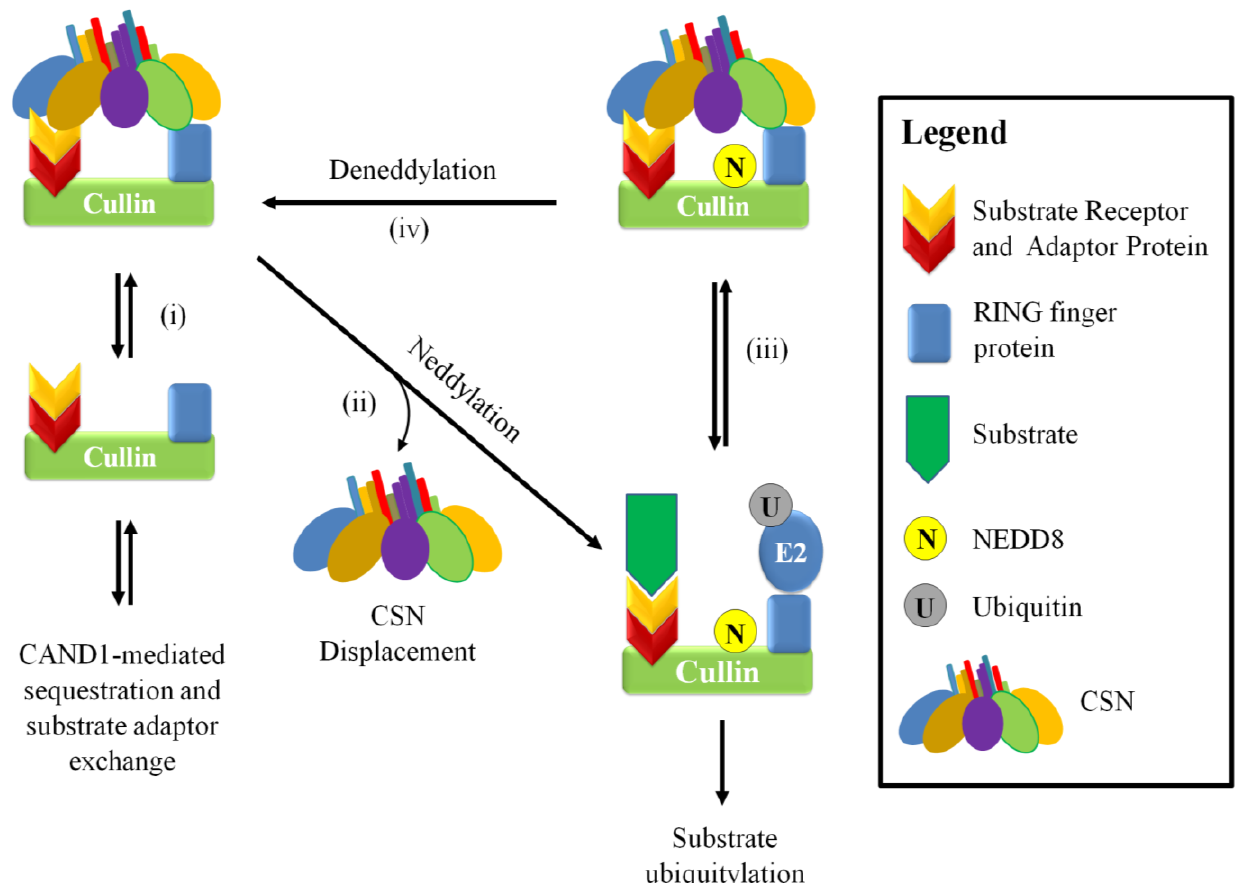
Figure 3. A schematic model for the neddylation-dependent regulation of CRLs by the CSN. The CSN can bind and inhibit substrate ubiquitylation in a neddylation dependent manner. Deneddylated CRLs can be a substrate for CAND1-mediated cullin sequestration and substrate adaptor exchange (i), but it can be activated through neddylation and CSN displacement to promote substrate and E2 binding and subsequent substrate ubiquitylation (ii). Interaction between the CRL to the CSN (iii and Figure 5) positions and activates CSN5 to allow deneddylation to occur